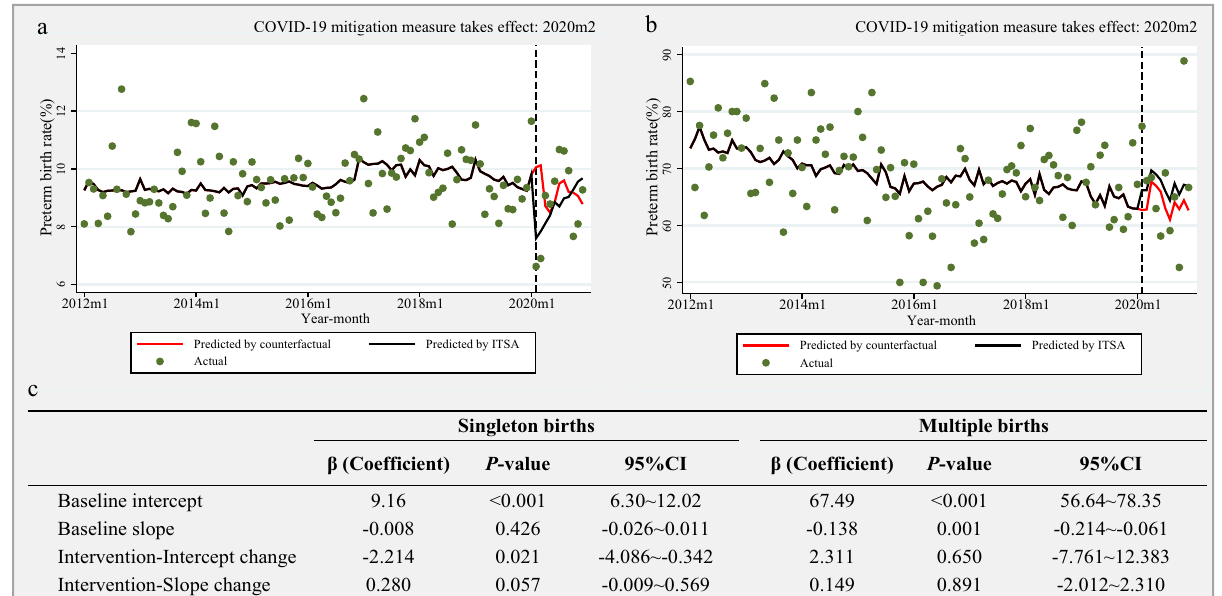
Fig. 3 | Interrupted time series analysis (ITSA) of the preterm birth rate across different type pregnancies in Wuhan, 2012 – 2020. a singleton births; b multiple births; c the result of ITSA across different type pregnancies. Dots indicate true monthlypretermbirthratesandsolidlinesindicatethemeanofestimatedpreterm birth rates per month by ITSA model, and red solid lines indicate the mean of estimated preterm birth rates per month assuming that COVID-19 mitigation